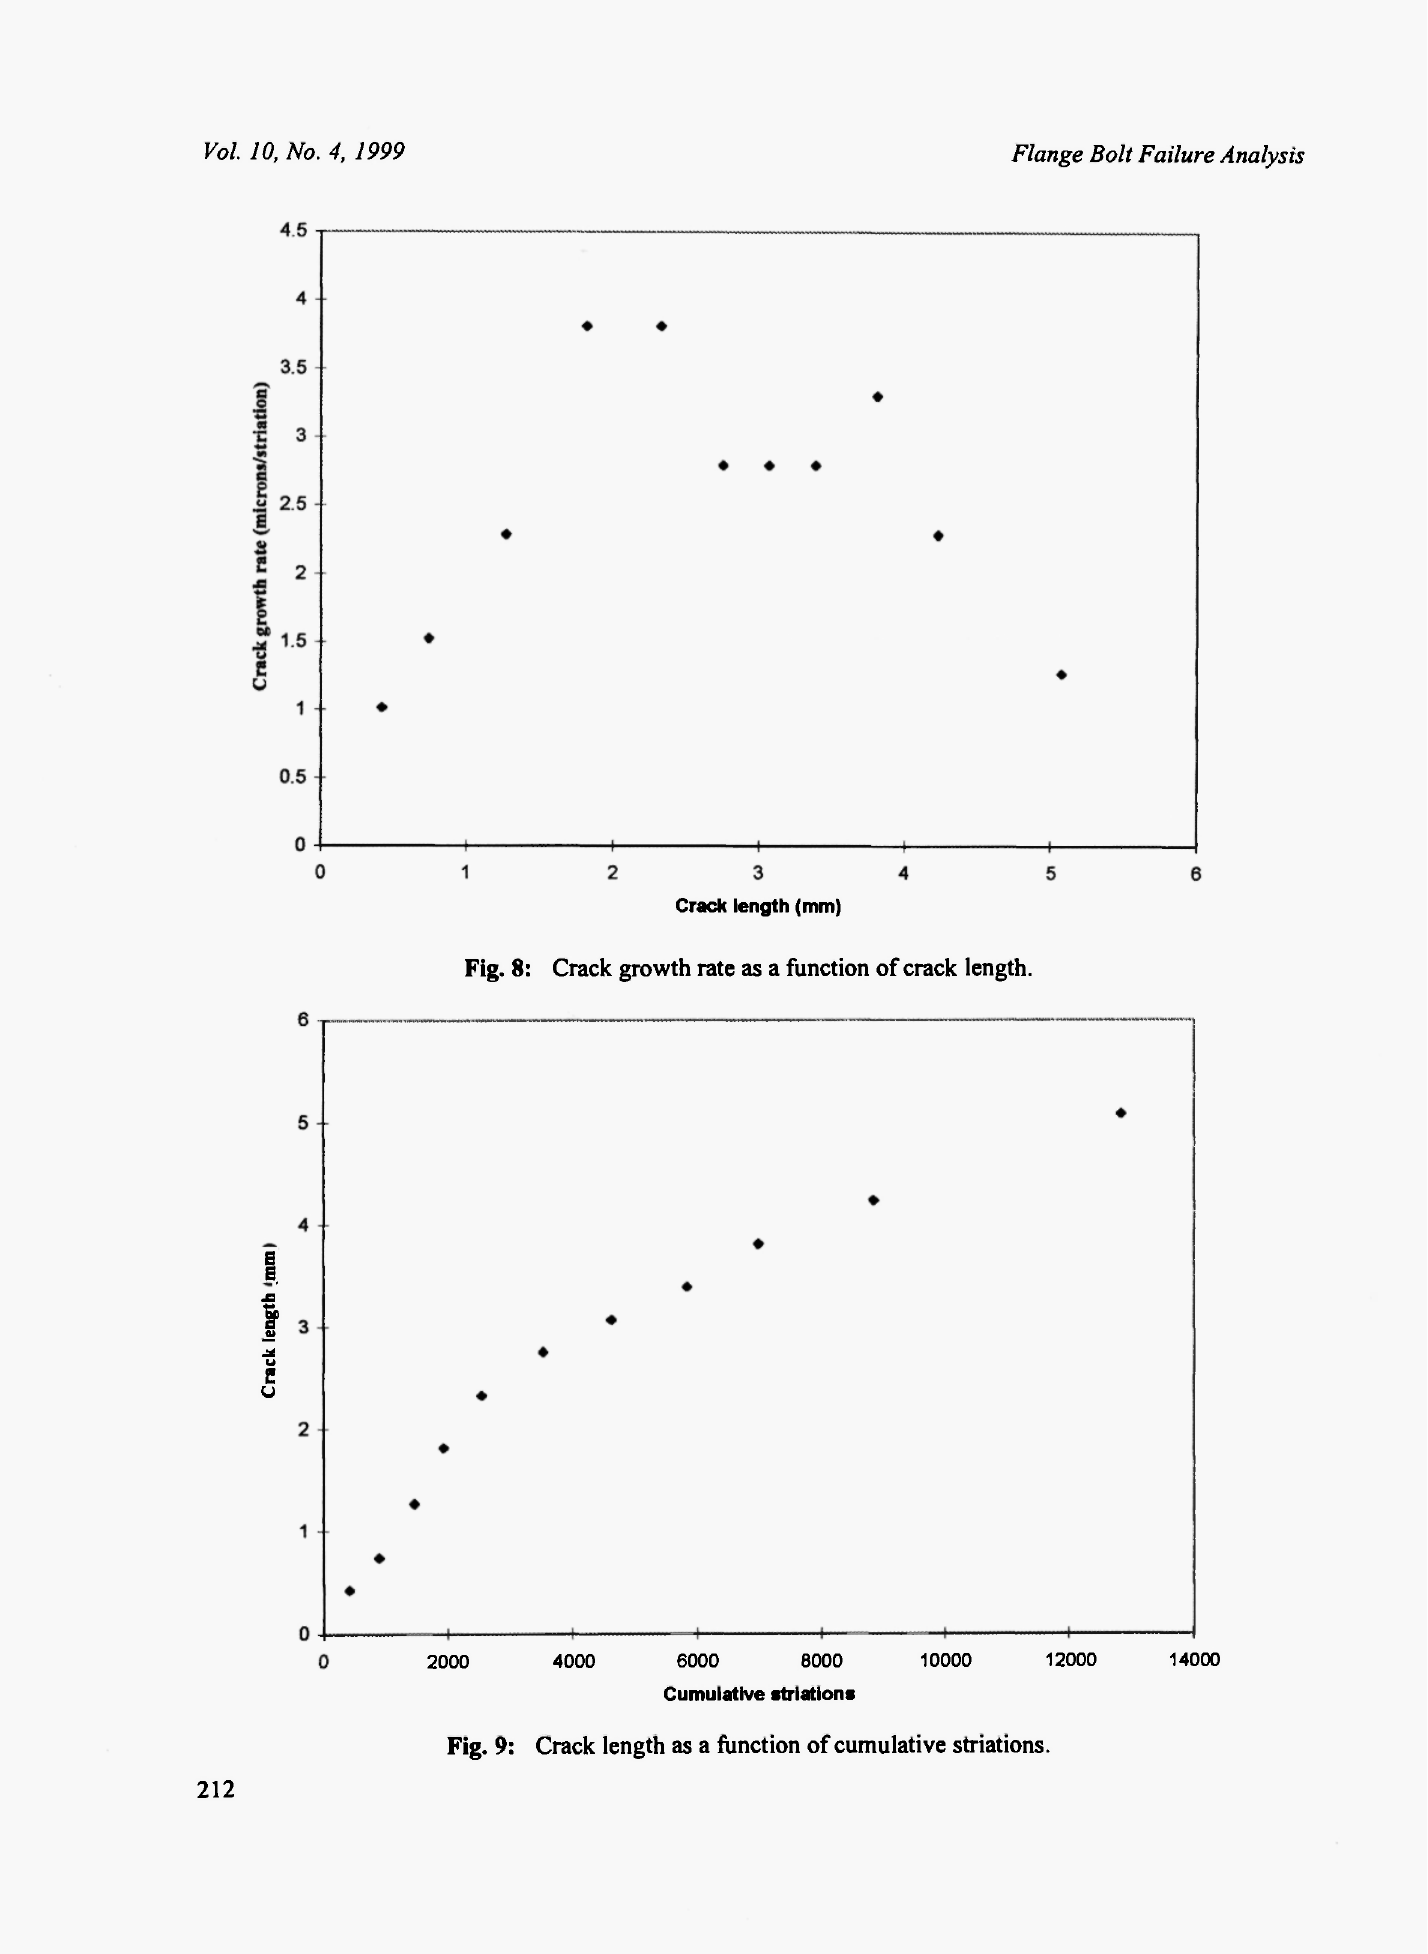
Fig. 9: Crack length as a function of cumulative